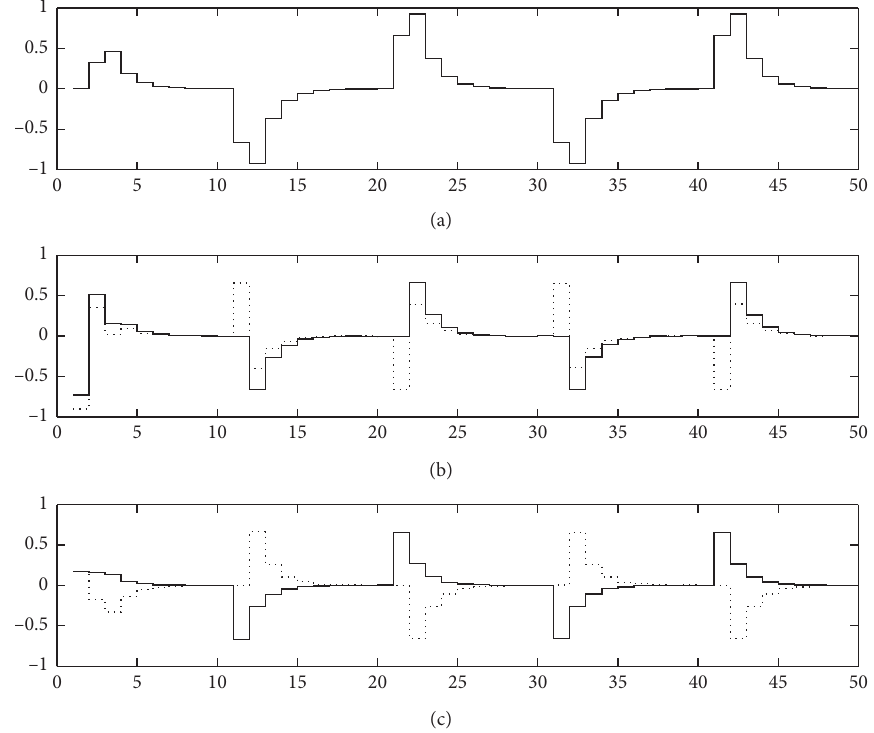
Figure 4: Tracking control of discrete-time chaotic system with trajectories (a) x